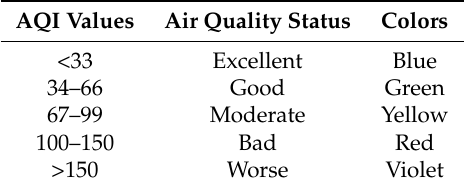
Table 4. Air quality index (AQI) values in relation to the air quality